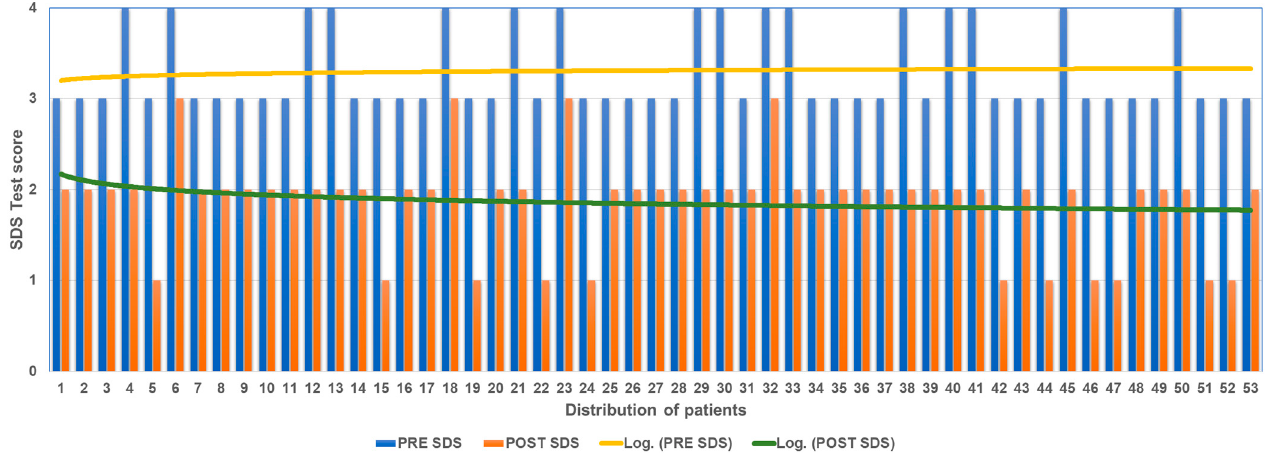
Figure 2. NAS score before and after ANM treatment.